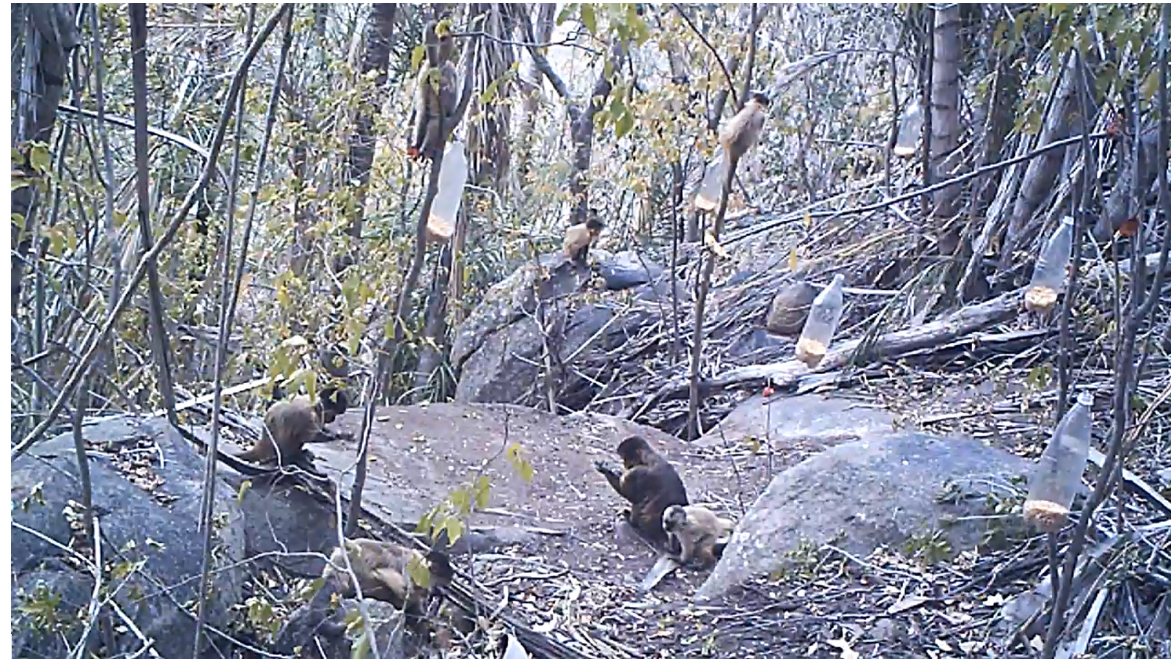
Figure 2 . Camera trap image confirming the species identity. The image shows a group of S. libidinosus at Serra do Estrago, Pernambuco, Northeast